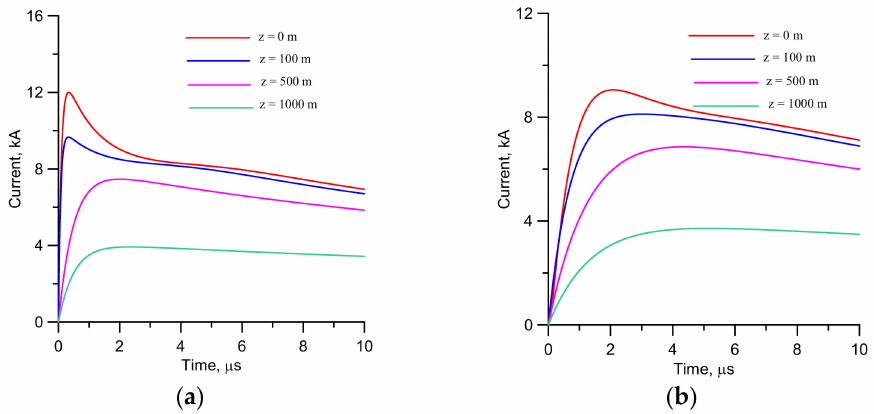
Figure 6. Return stroke current at several heights calculated for ( a ) σ = 5 S/m, ε r = 80 and ( b ) σ = 0.0001 S/m and ε r =